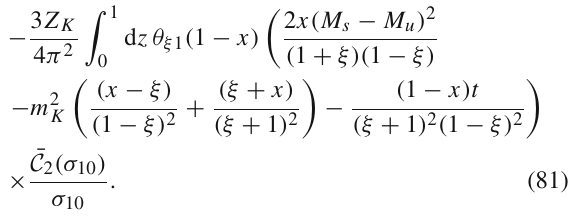
Fig. 11 Left panel – f